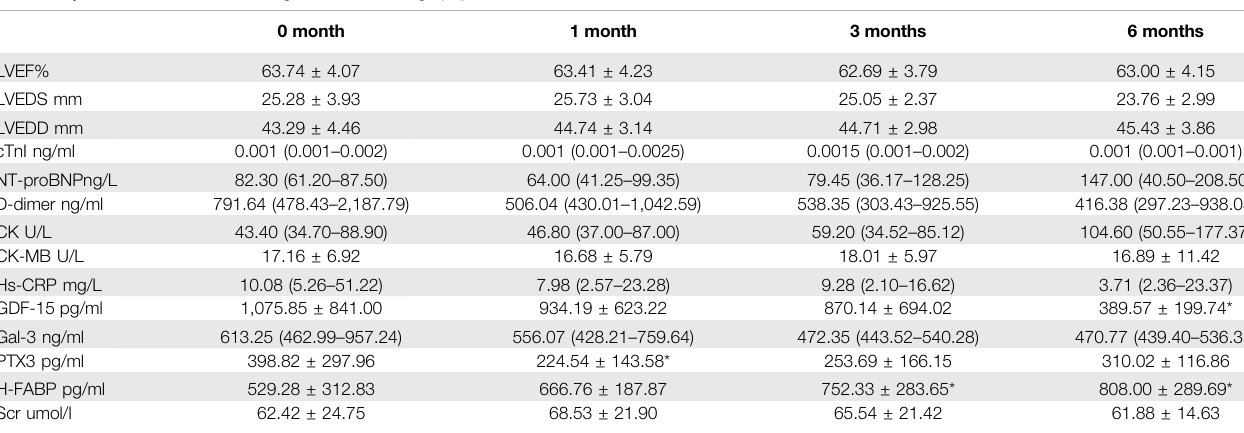
TABLE 2 | Baseline and Interval Changes in Echocardiography and Biomarker Levels Between Baseline and 1, 3 and 6 months. 0 month 1